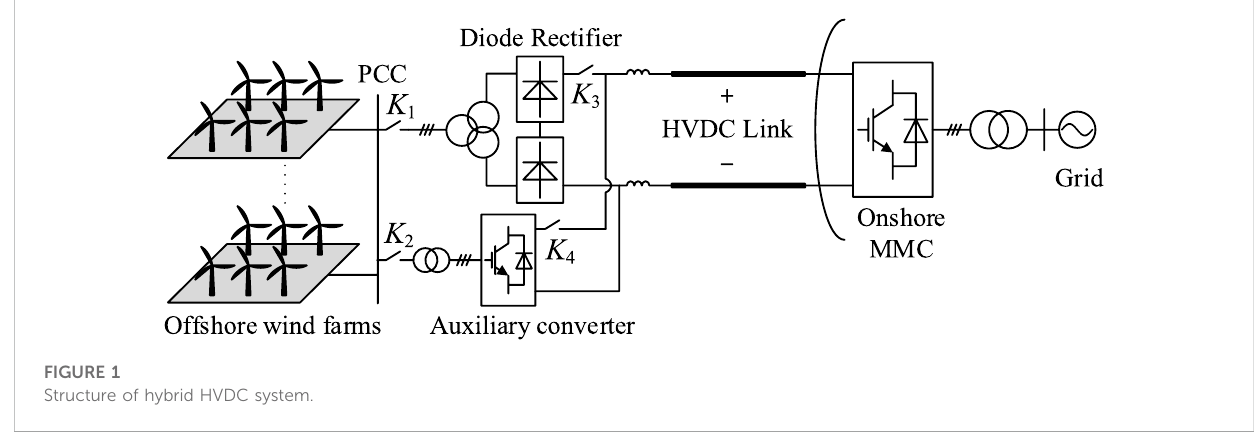
FIGURE 1 Structure of hybrid HVDC system.